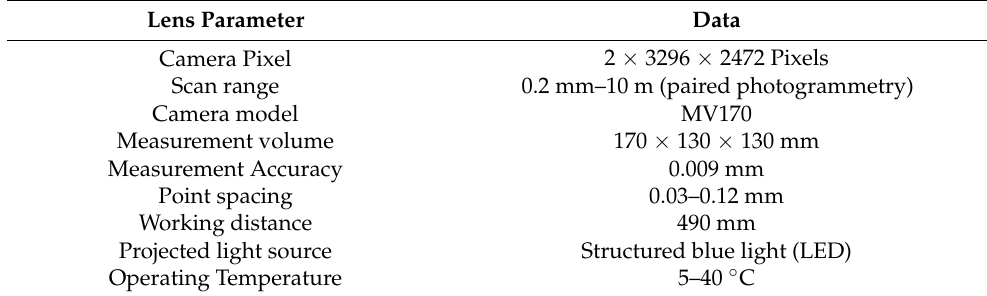
Table 1. Parameters of the measurement system. Lens